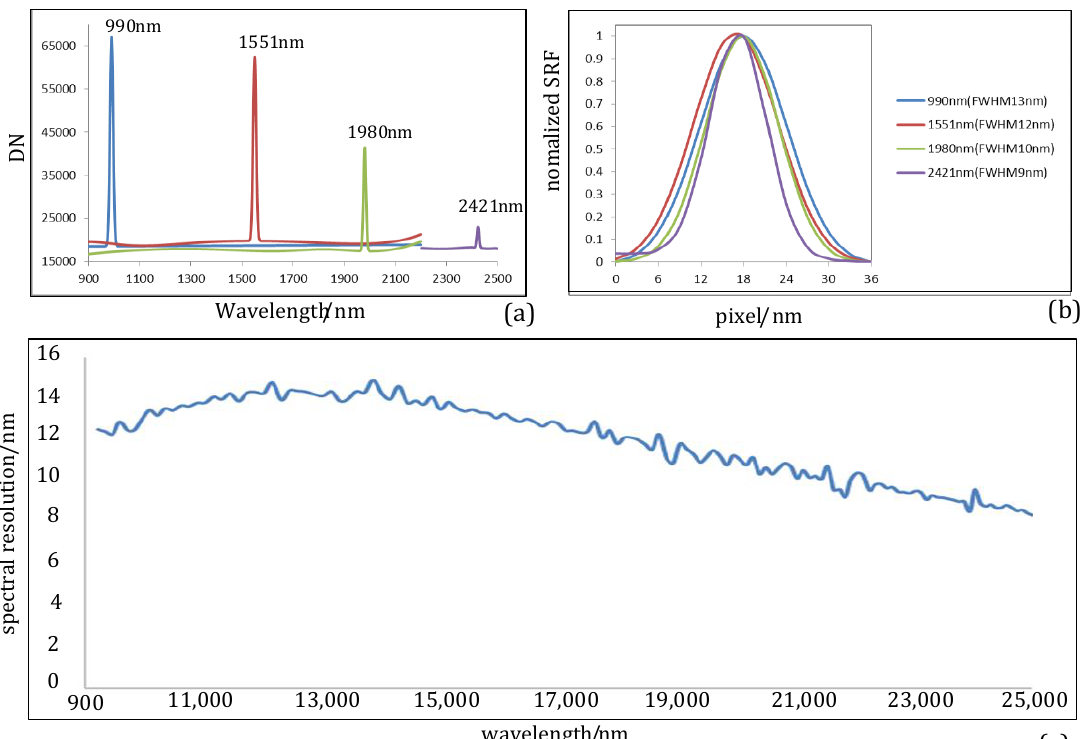
Figure 9. ( a ) SRFs of typical wavelengths; ( b ) FWHM curve of typical wavelengths; ( c ) measured spectral resolutions of the prototype in the SWIR spectrum.